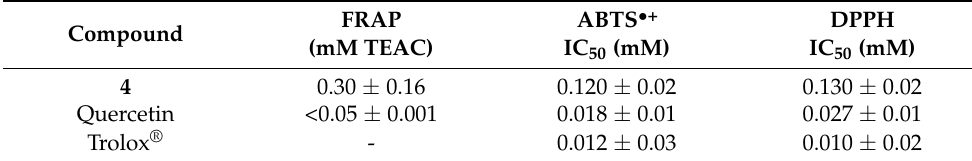
Table 3. Antioxidant activities of octanoylbenzohydroquinone 4 .